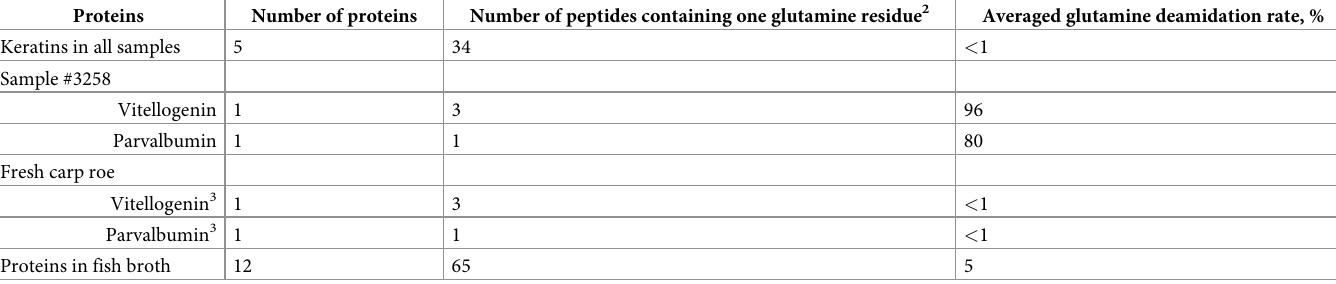
Table 2. Glutamine deamidation rates in fish proteins detected in #3258 and modern reference samples 1 . Proteins Number of proteins Number of peptides containing one glutamine residue 2 Averaged glutamine deamidation rate,